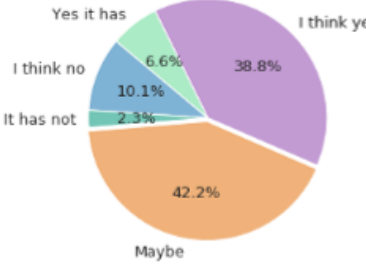
Figure 9: Consequences of MHD on career